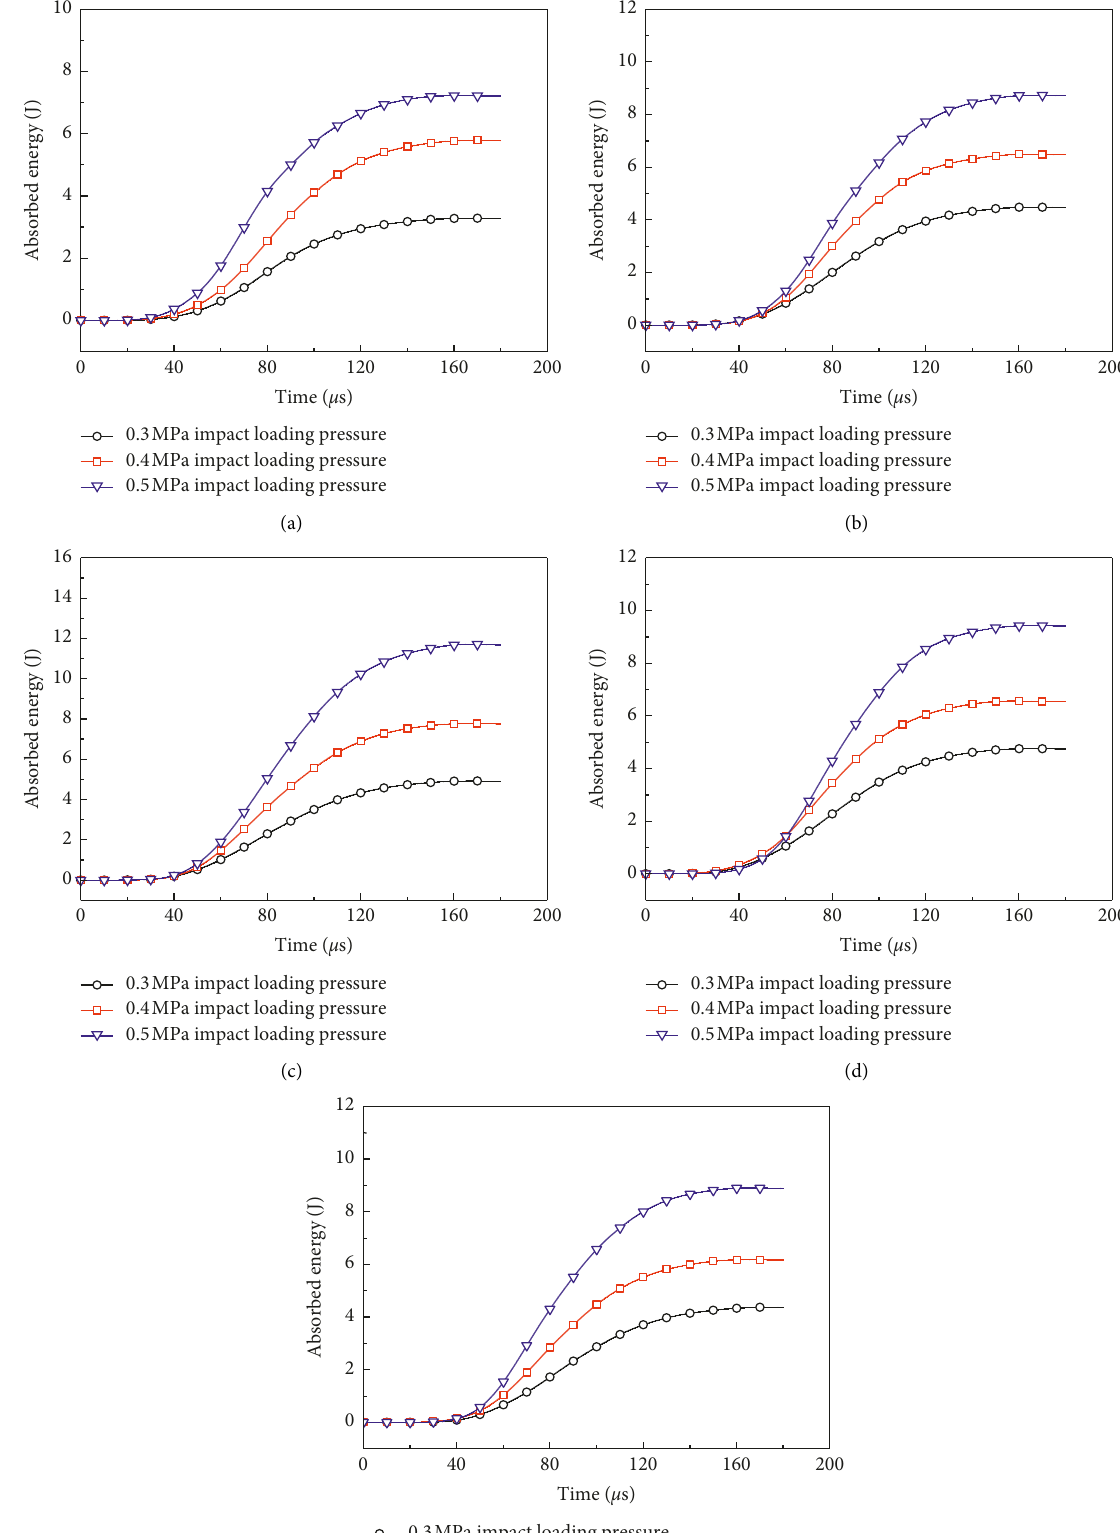
Figure 15: Curves of energy versus time for basalt fiber-reinforced cement-fly ash-stabilized soil. (a) BF � 0%. (b) BF � 0.3%. (c) BF � 0.6%. (d) BF � 0.9%. (e) BF �